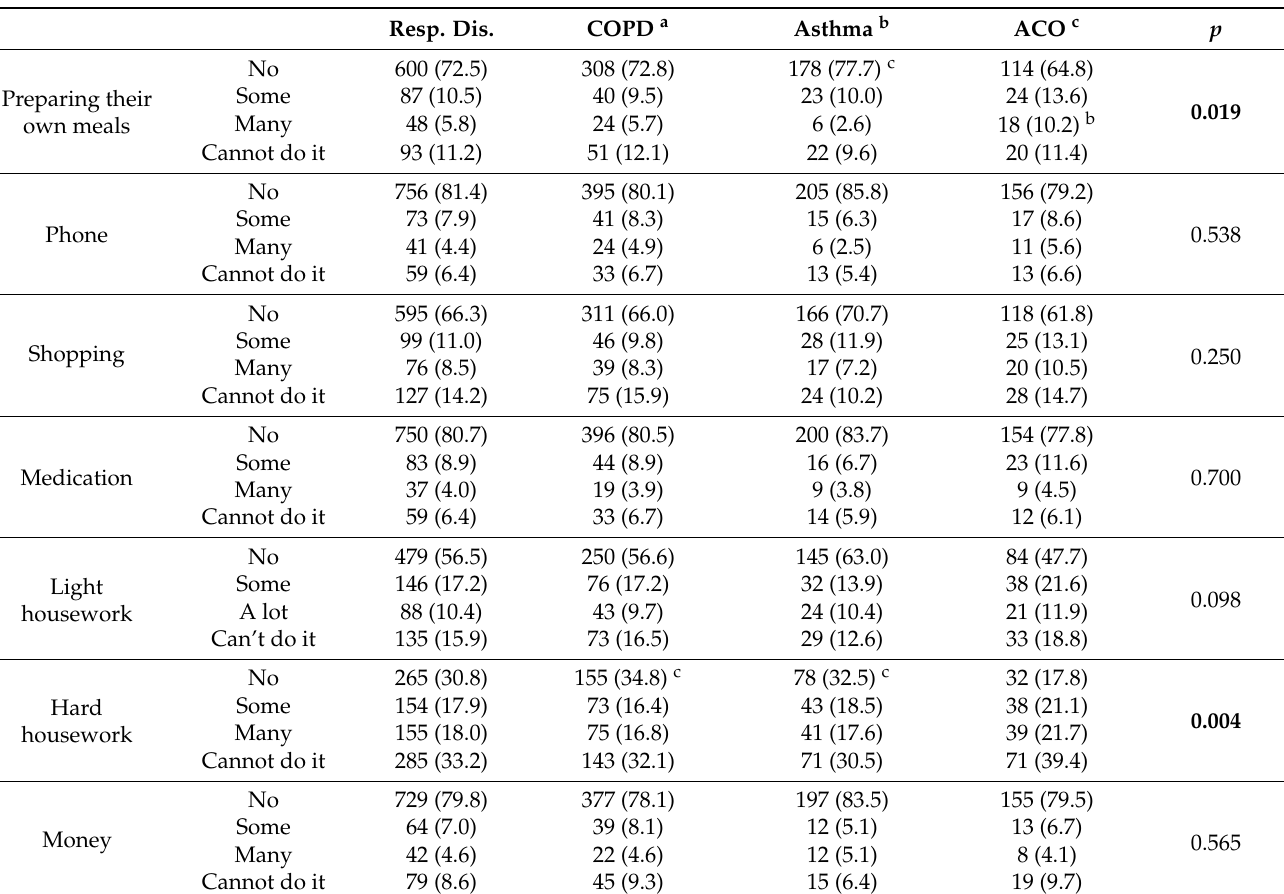
Table 3. Limitations in performing Instrumental Activities of Daily Living (IADL) in older adults with COPD, asthma, or ACO. Resp. Dis. COPD a Asthma b ACO c